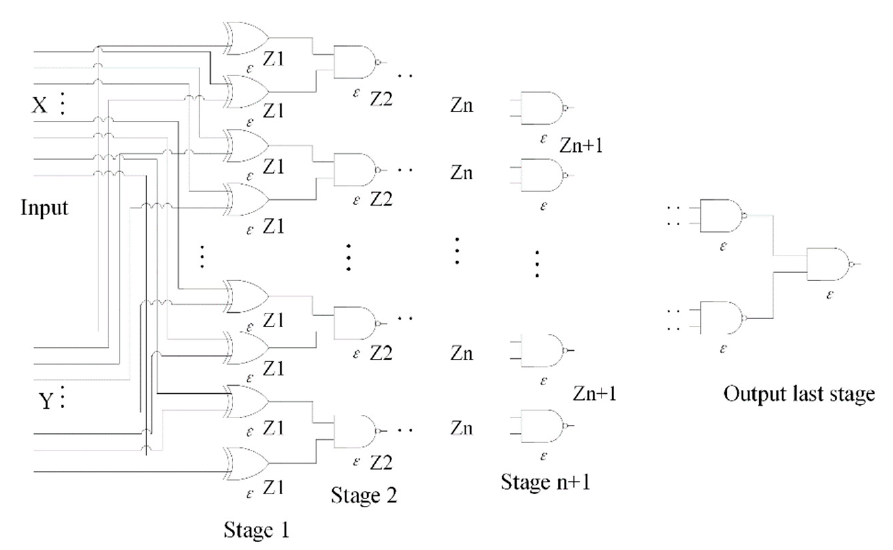
ε ε . Figure 6. Schematic of a full binary tree whose nodes are XOR and NAND gates with